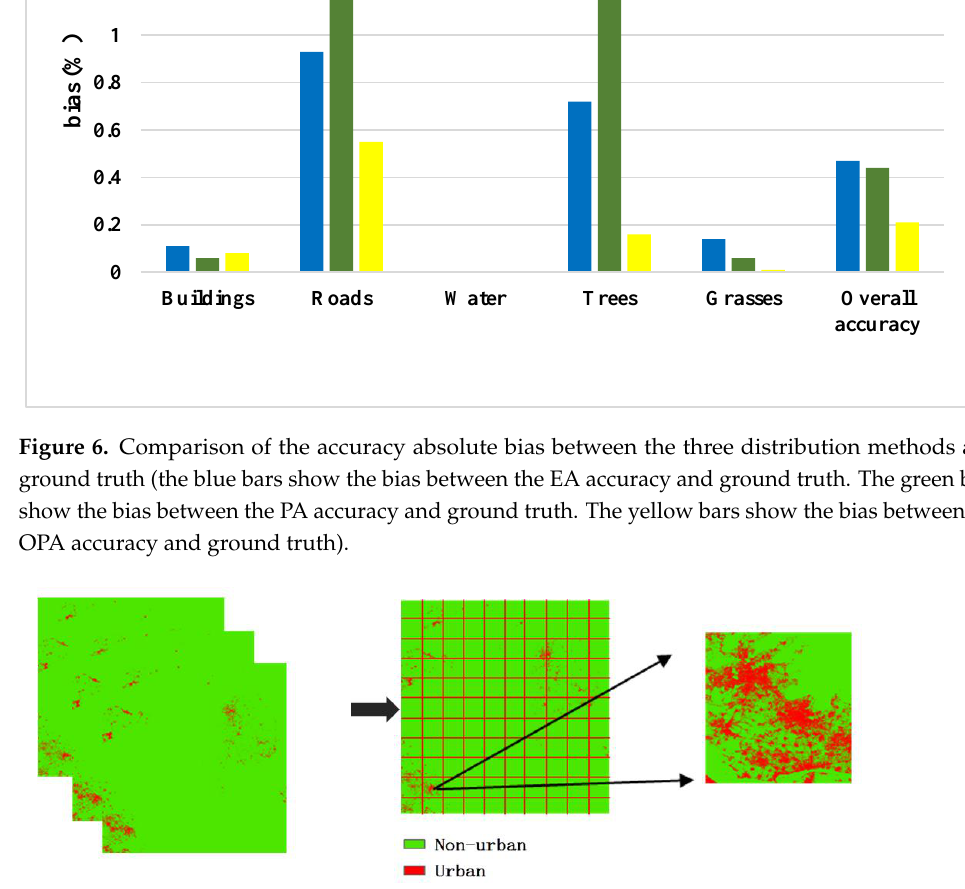
◦ × 10 ◦ map sheets divided into 1 ◦ × 1 ◦ map Figure 7. 10° × 10° map sheets divided into 1° × 1° map sheets. Figure 7. 10